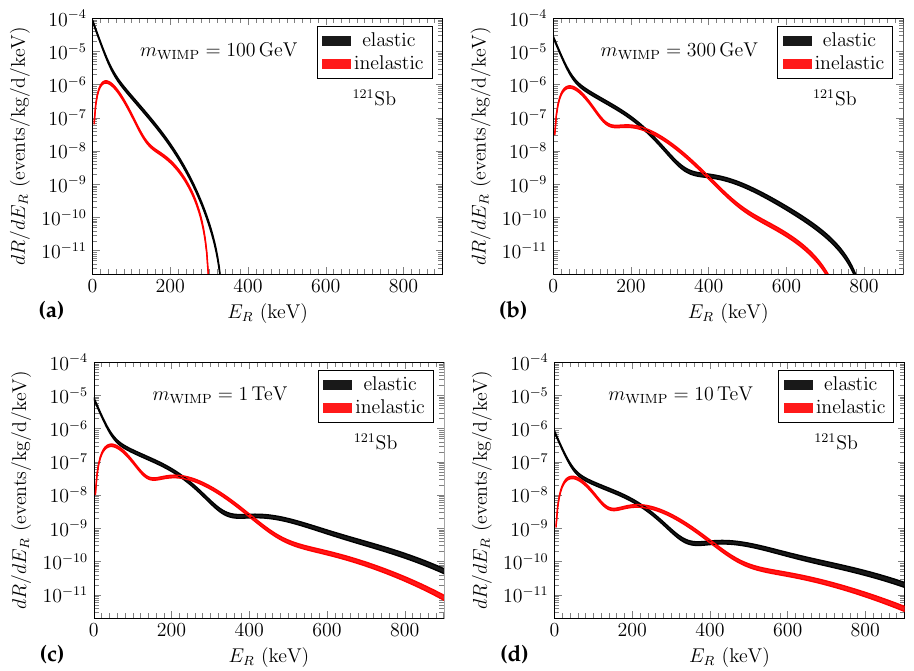
Figure 5. Differential event rates in 121 Sb with WIMP masses: ( a ) 100 GeV; ( b ) 300 GeV; ( c ) 1 TeV; and ( d ) 10